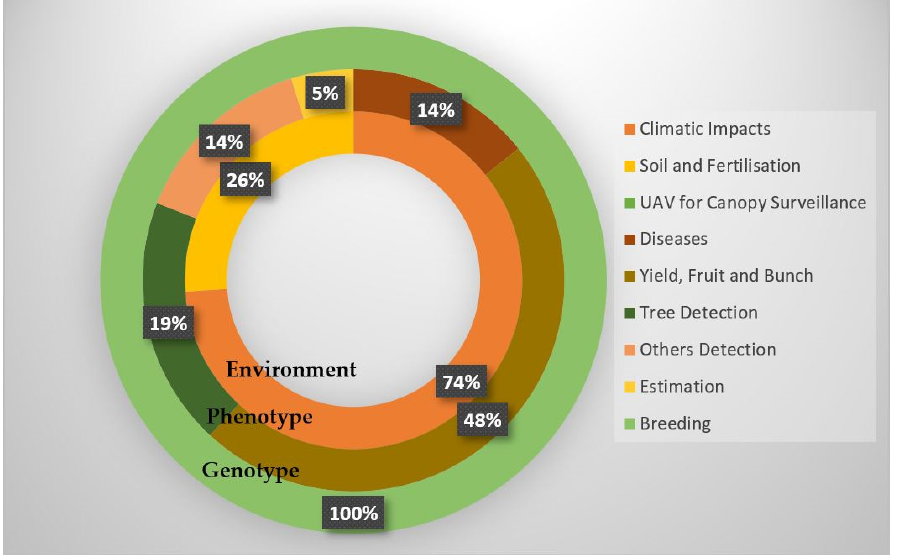
Figure 5. Factors